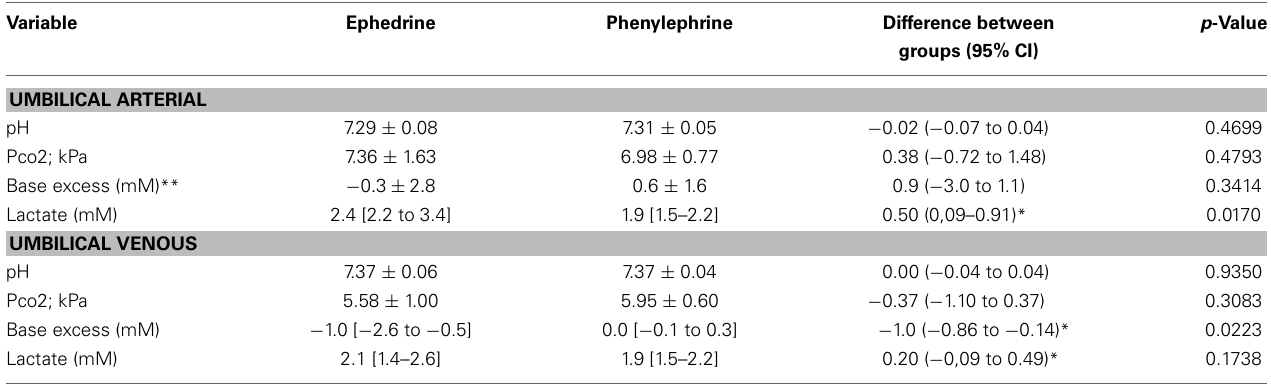
Table 3 | Umbilical cord blood analysis.